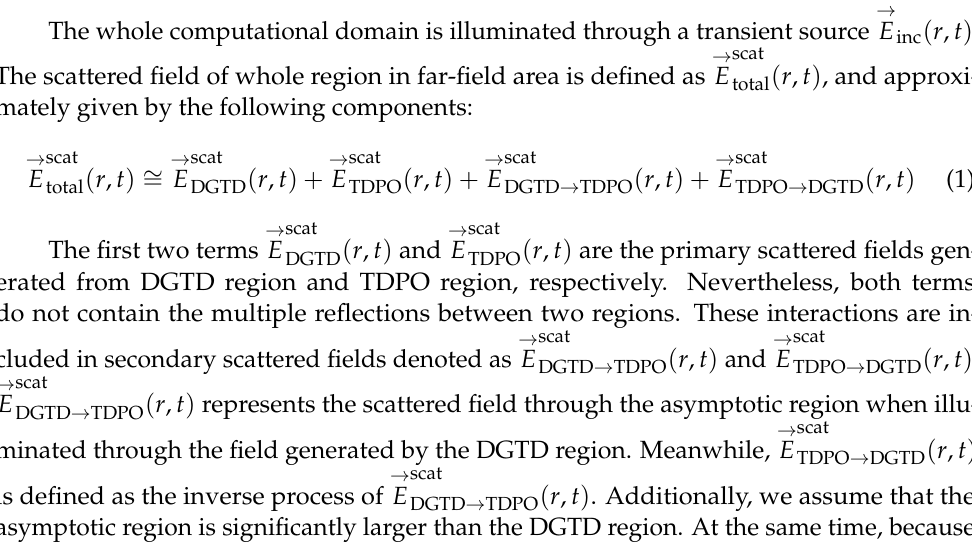
Figure 1. Combined contributions of the two regions.